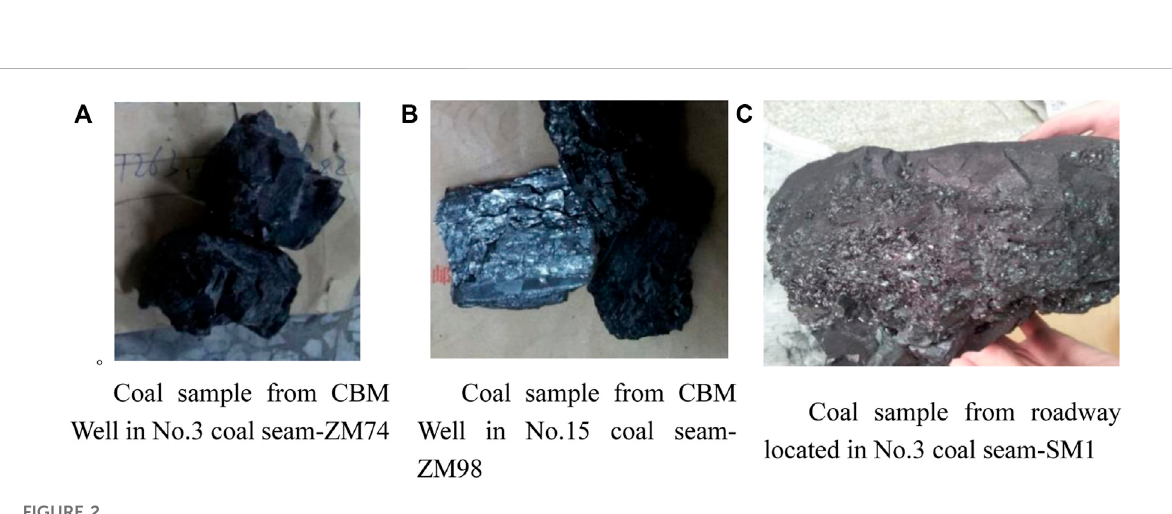
FIGURE 2 Different coal